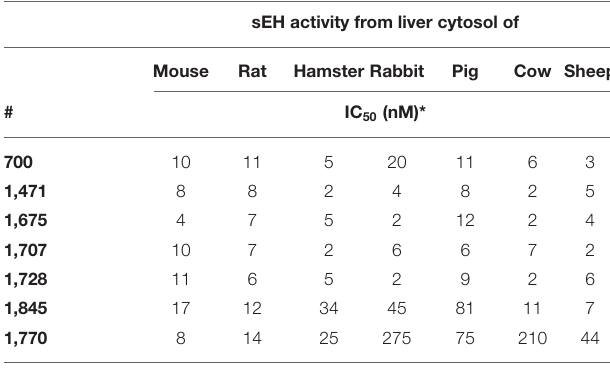
TABLE 4 | Inhibition potency of the selected compounds for the sEH from other animals of veterinary medicine